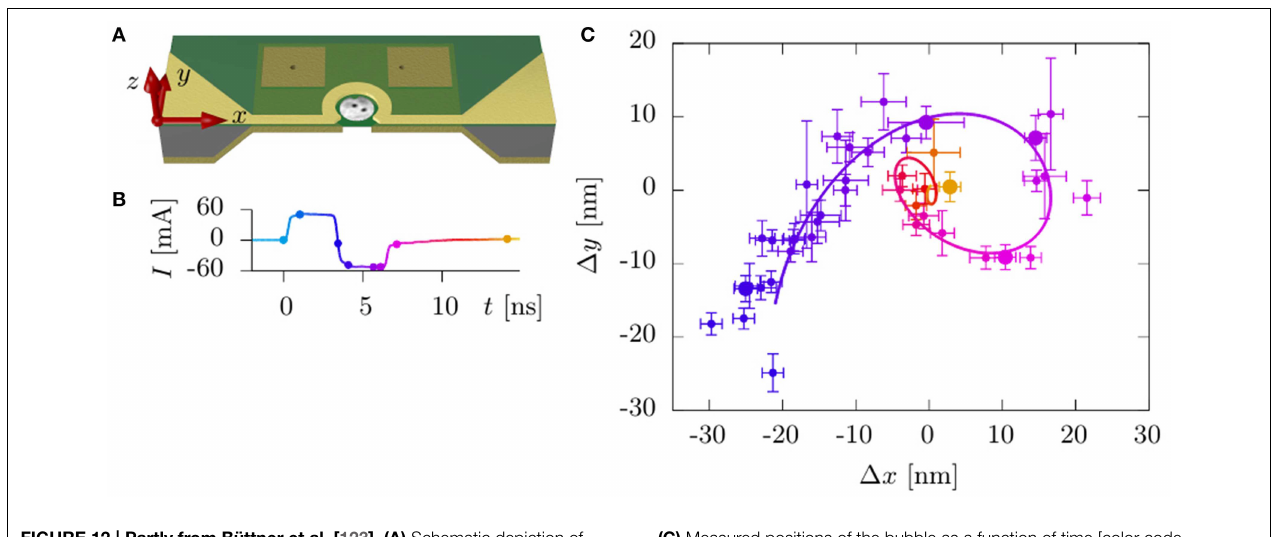
FIGURE 12 | Partly from Büttner et al. [123]. (A) Schematic depiction of the experimental setup. The CoB/Pt disc is surrounded by a gold stripline that generates a field. (B) The shape of the bipolar current pulse.